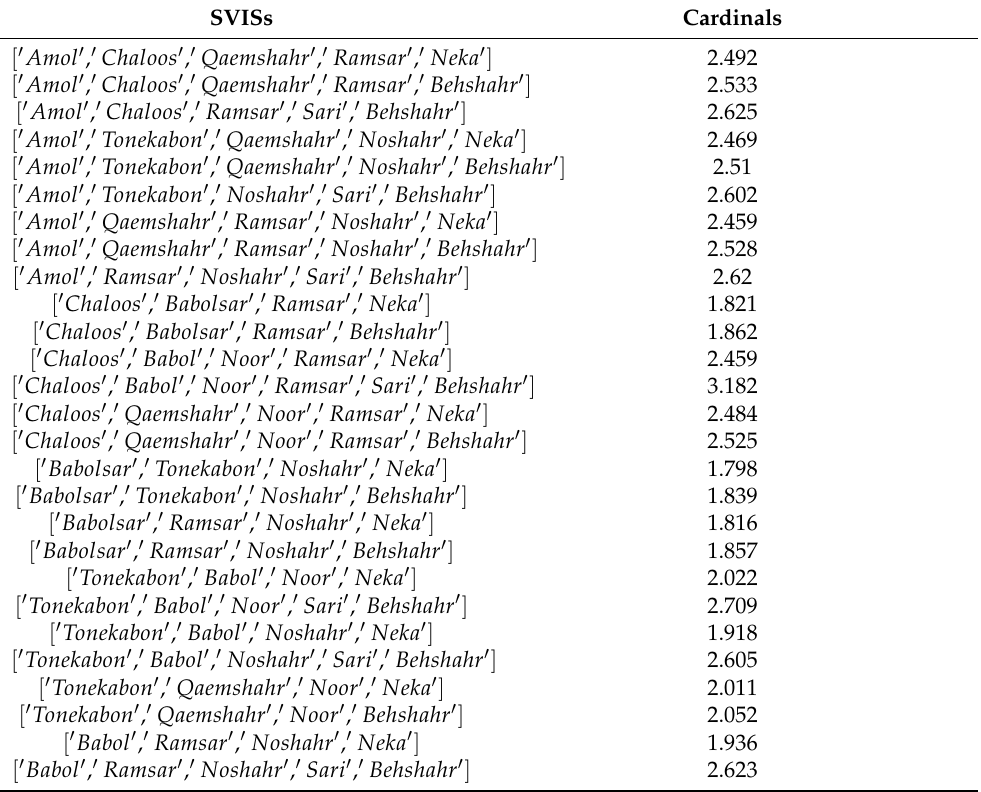
Table 8. Calculation of SVISs by Sage